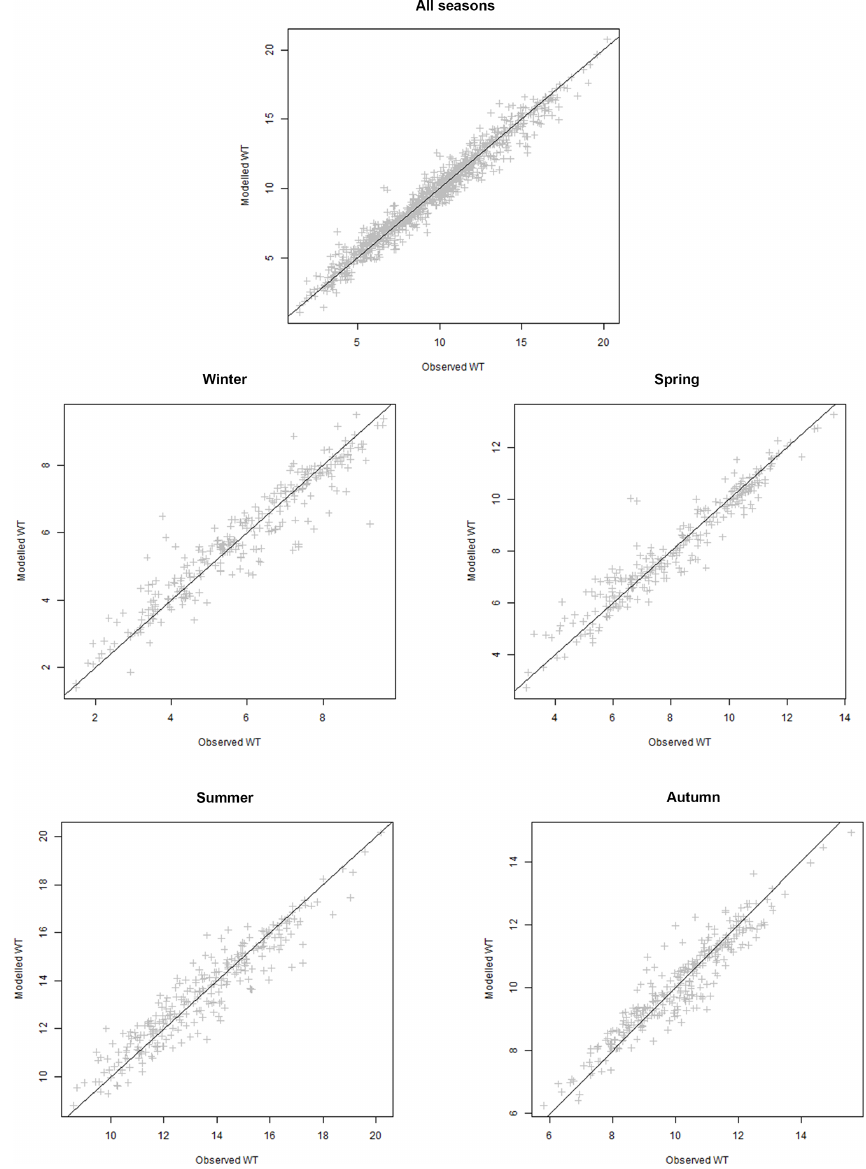
Figure 4. Plots of observed and modelled water temperature for the five models.